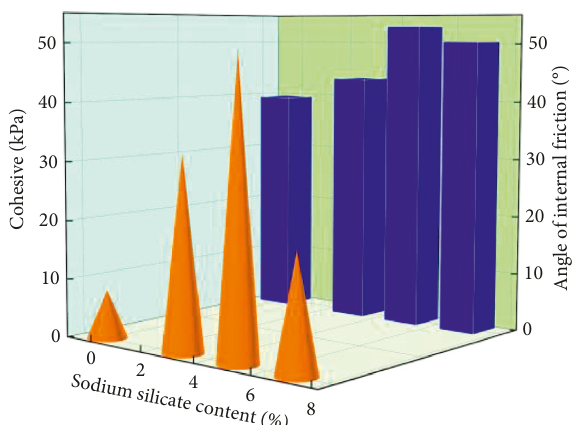
Figure 8: The friction angle and cohesion in the lunar soil simulant change with the content of sodium silicate.